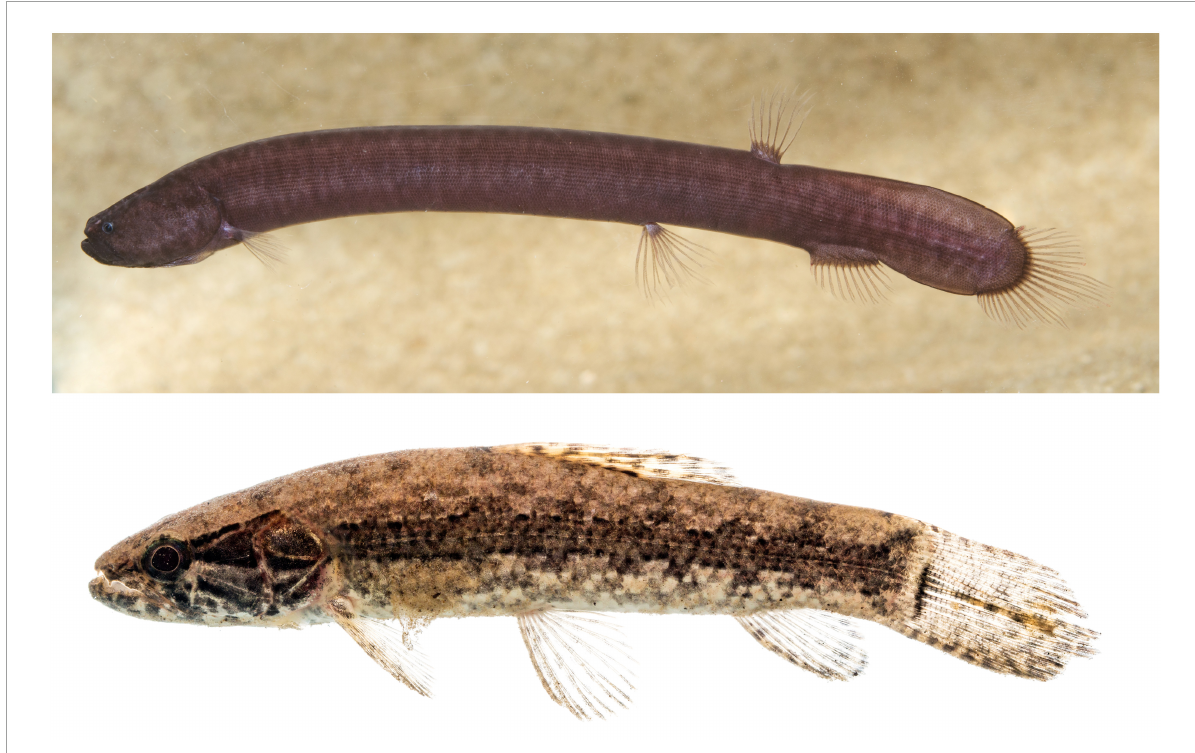
FIGURE1 Live specimens of Tarumania walkerae (top), Brazil, Rio Tarumã-Mirim, lower Rio Negro, Amazon basin (photography by Douglas Bastos); Hoplias malabaricus (bottom), Colombia, Río Manacacías, Orinoco basin (photography by Jorge García-Melo, Proyeto CaVFish Colombia).